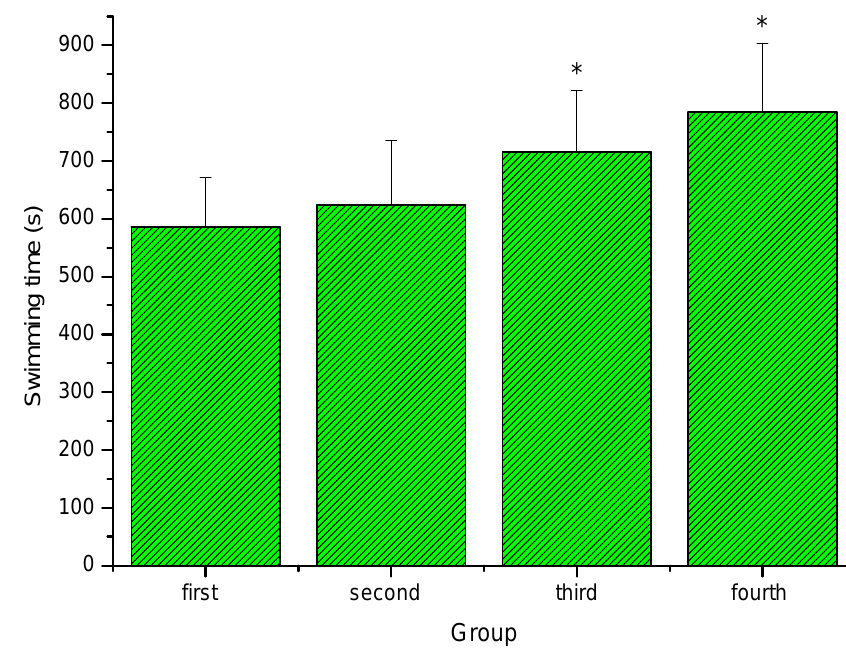
Figure 2. Effect of ASSE on swimming time to exhaustion of mice. Values represent the means ± SE (n = 10 per group). * P < 0.05 when compared to control